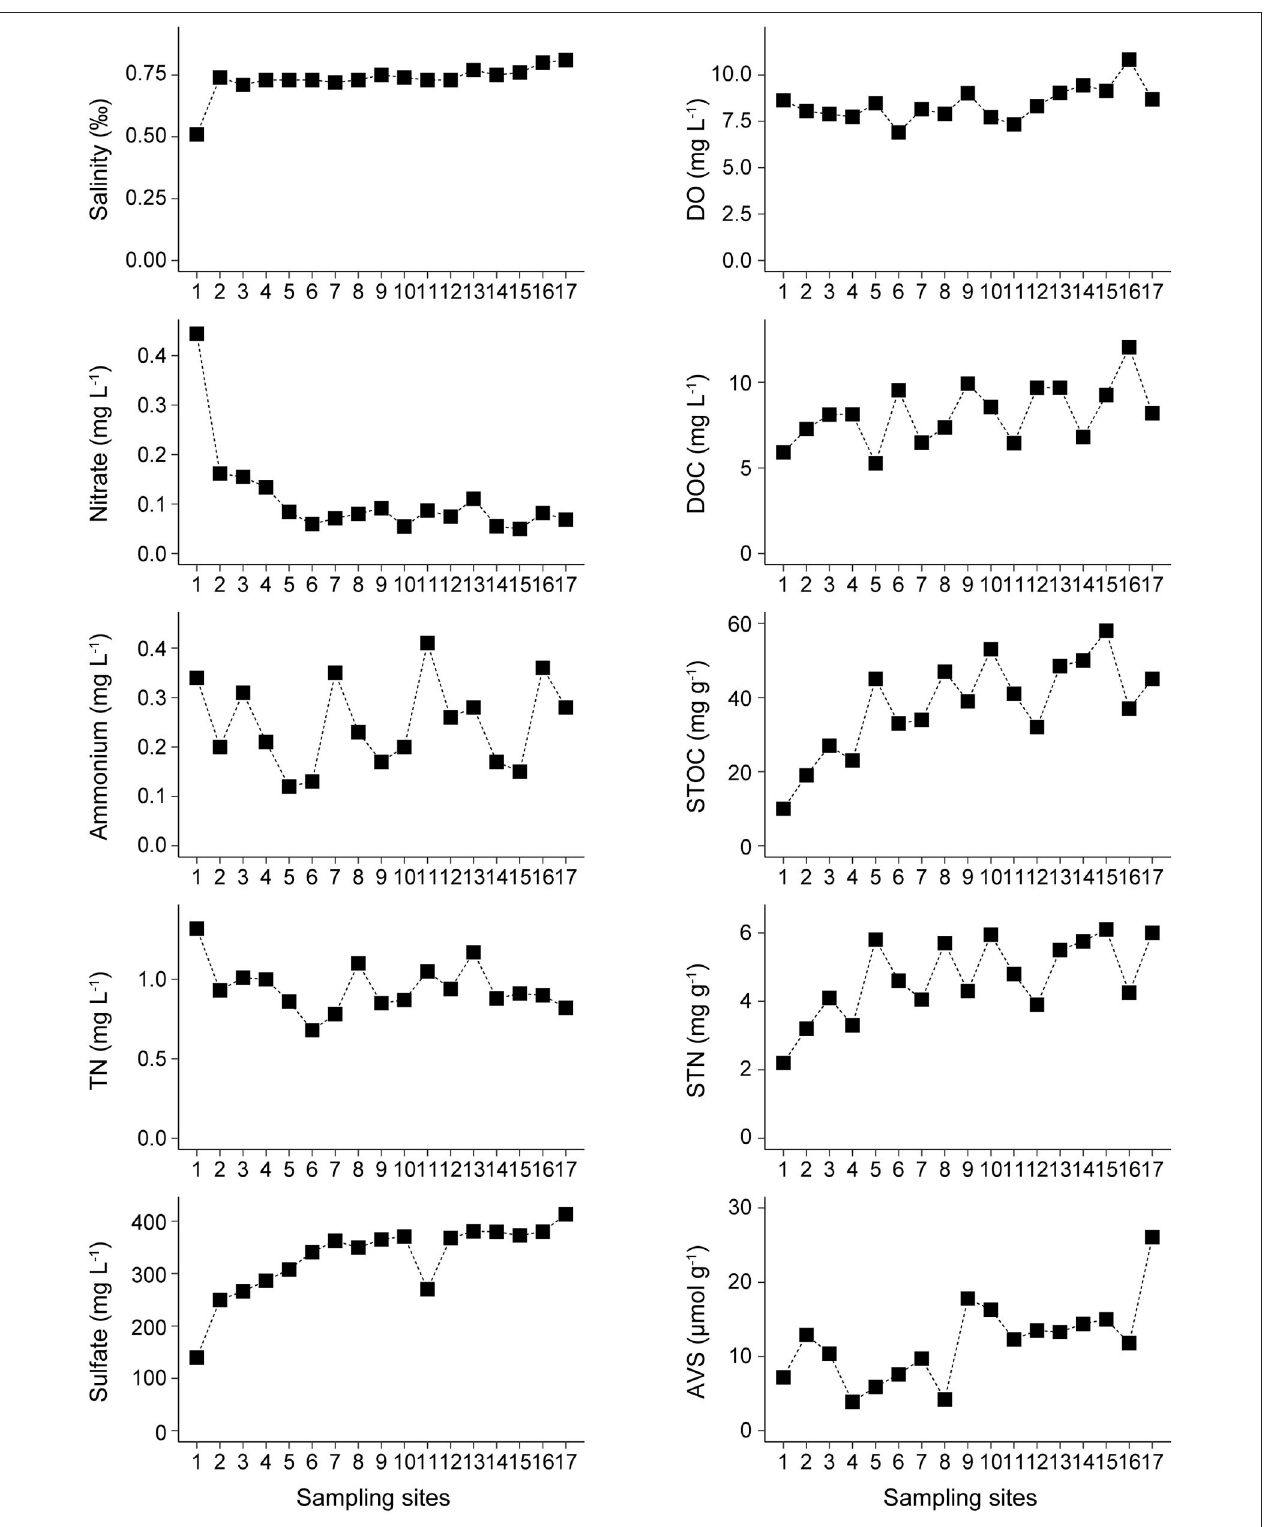
FIGURE 2 | Spatial distribution of the physicochemical parameters in the overlying water [Salinity, Dissolved Oxygen (DO), Nitrate, Ammonium, Total Nitrogen (TN), Sulfate and Dissolved Organic Carbon (DOC)] and sediments [Sediment Total Organic Carbon (STOC), Sediment Total Nitrogen (STN) and Acid volatile sulfides (AVS)] in Lake